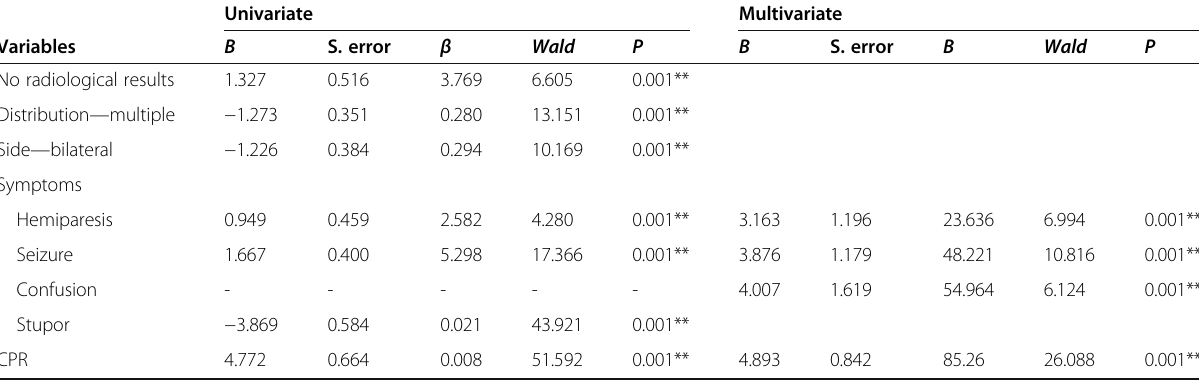
Table 4 Logistic regression analysis results for predicting life status with independent variables Univariate Multivariate